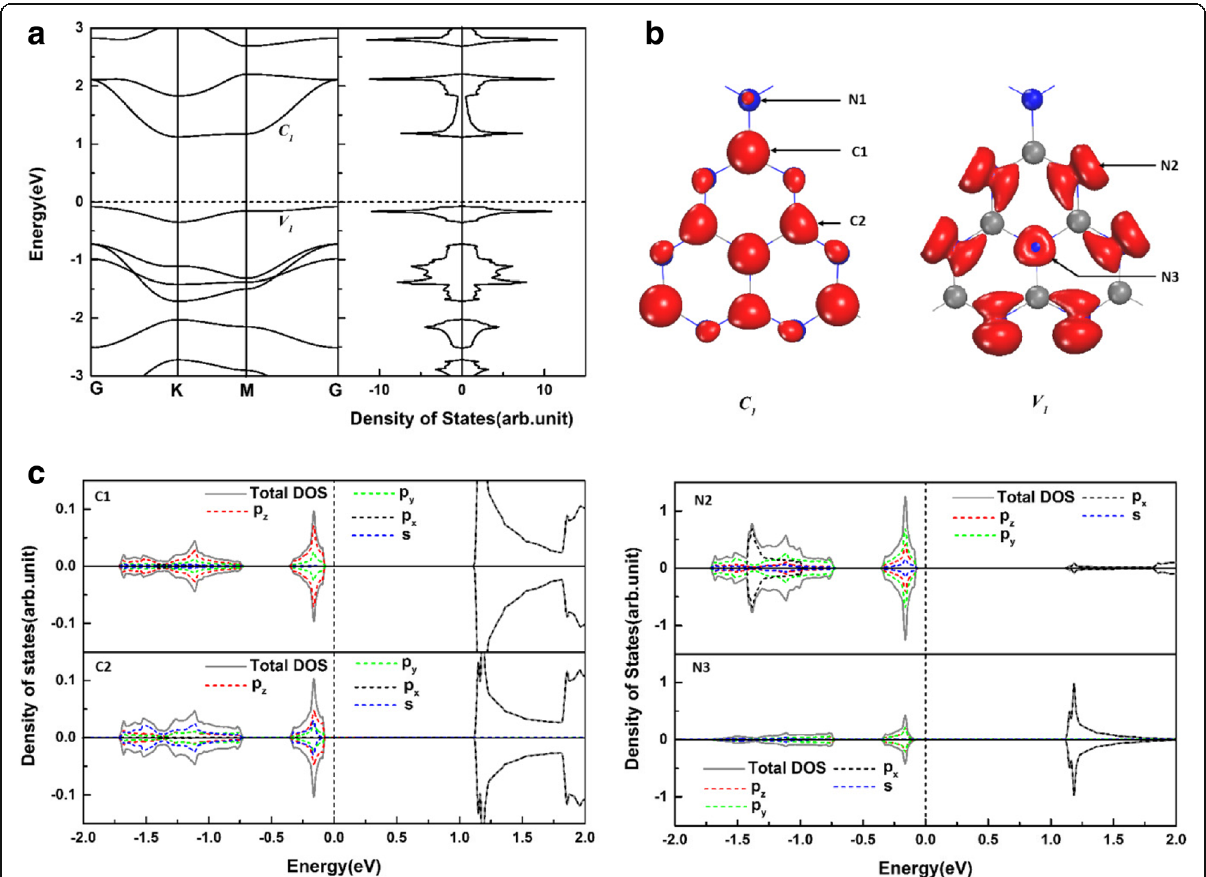
Fig. 2 a The electronic band structures and the total density of states of pristine gh-C 3 N 4 . b The charge distributions of the edge bands C 1 and V 1 (indexed in a ). c The orbital-resolved electron density of states projected onto C1 atom, C2 atom, N2 atom, and N3 atom (indexed in b ). The energy at the Fermi level is set to